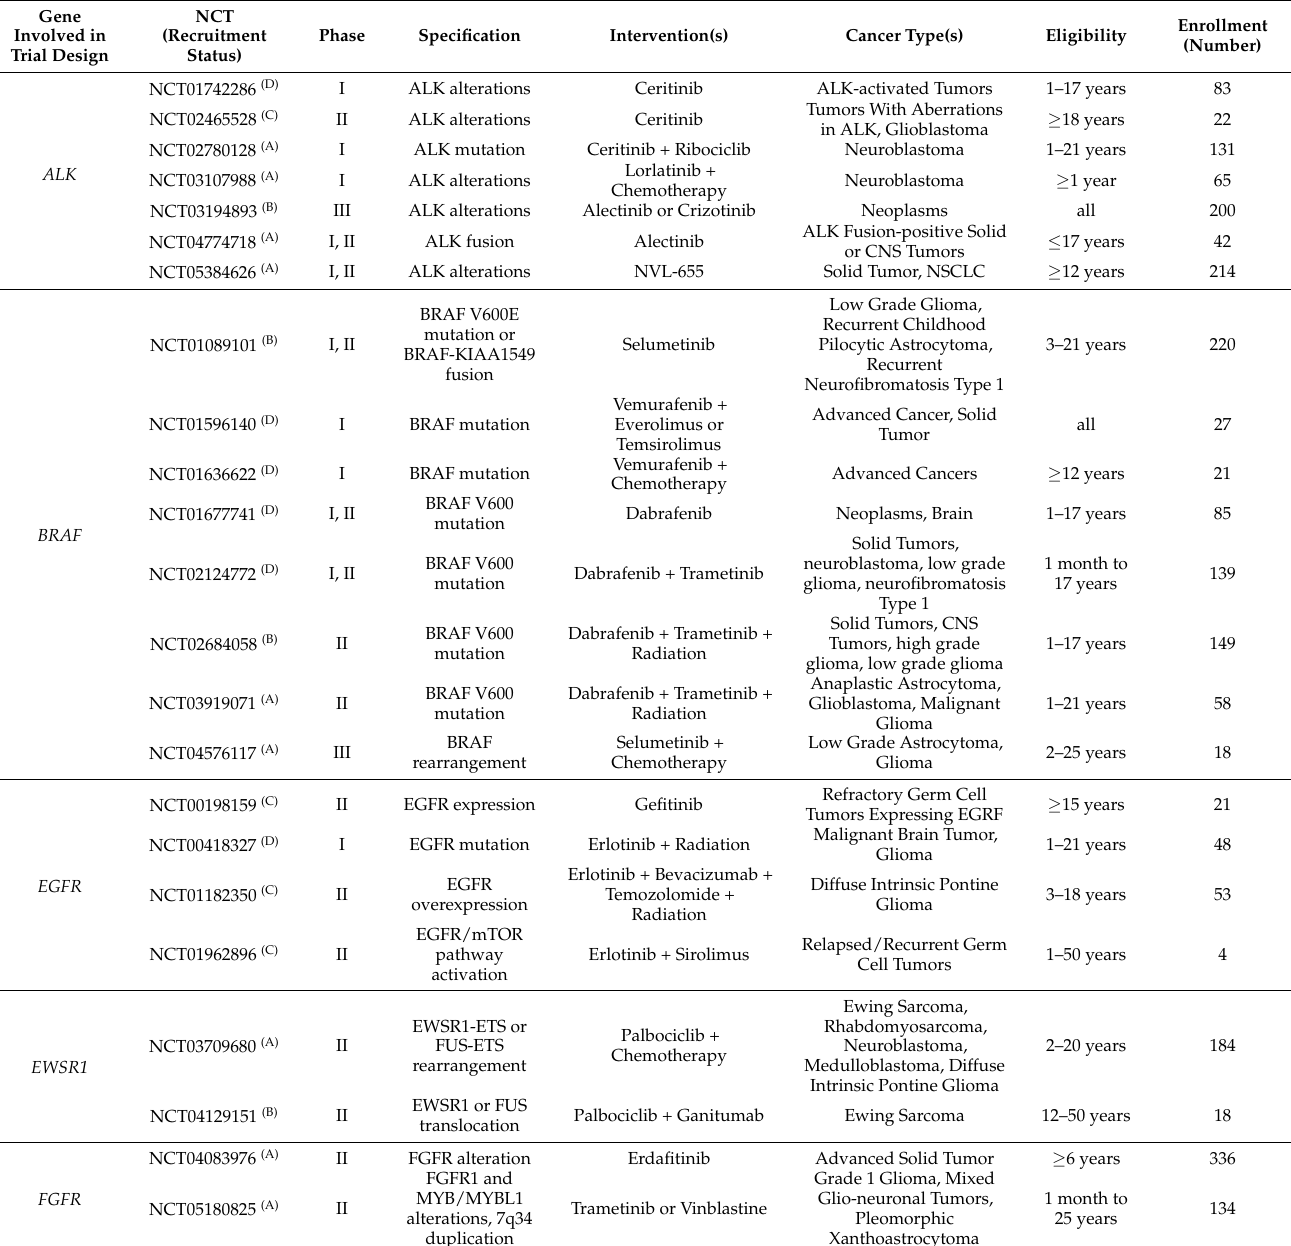
Table 5. Precision study designs for pediatric cancer: Single-arm